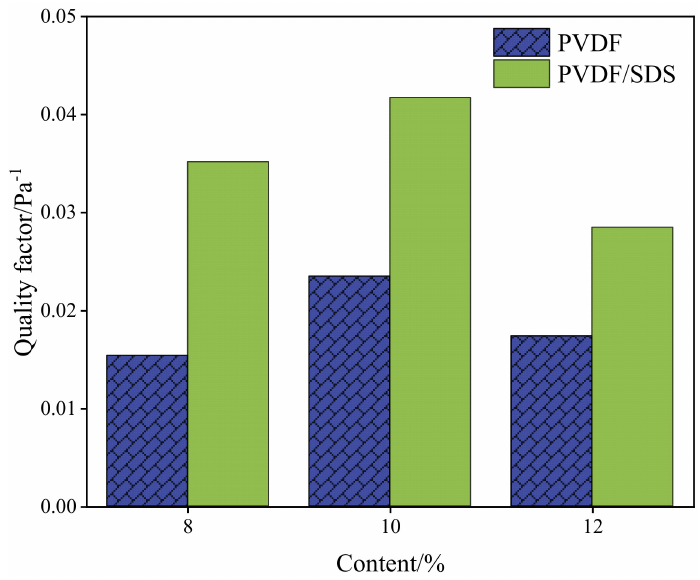
Figure 10. Quality factor of membranes.